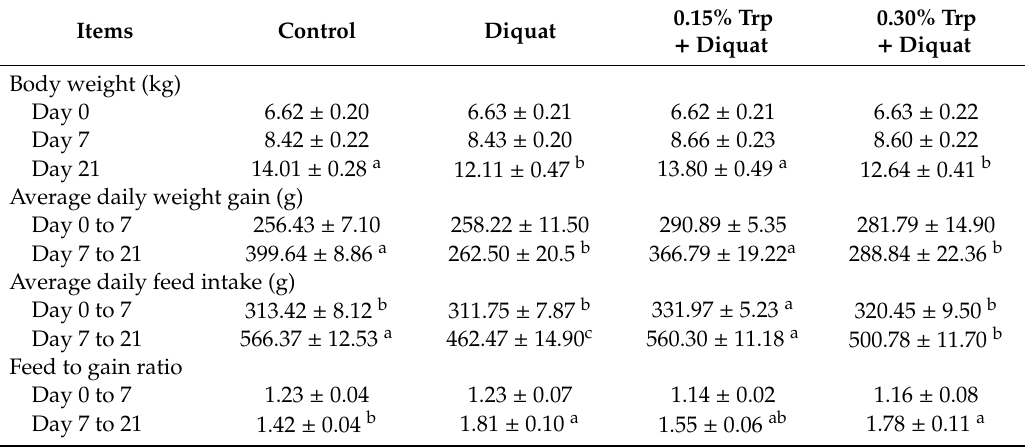
Table 4. E ff ects of dietary tryptophan supplementation on the growth performance of piglets challenged with diquat.